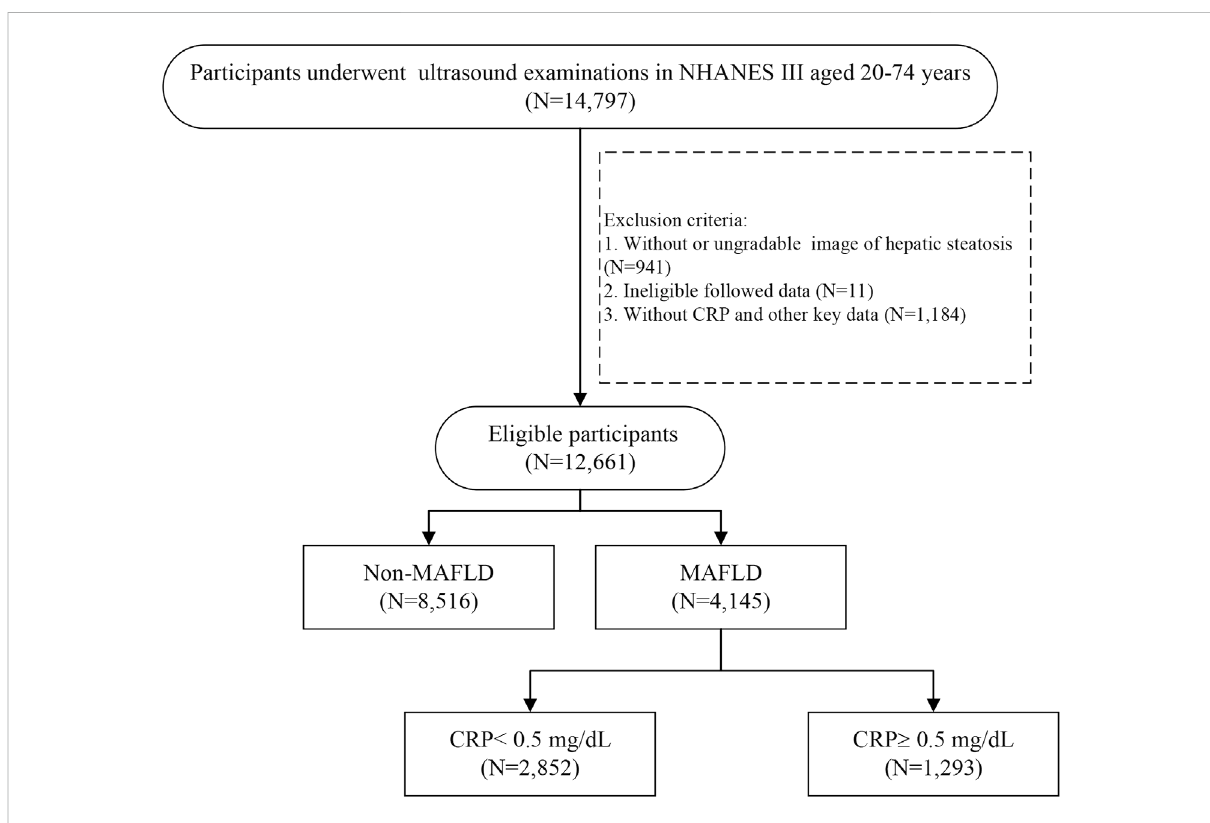
FIGURE 1 The fl ow chart of case